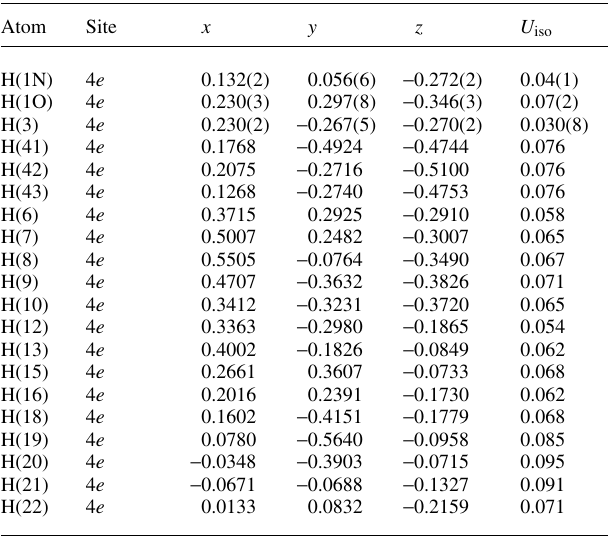
Table 2. Atomic coordinates and displacement parameters (in Å 2 )